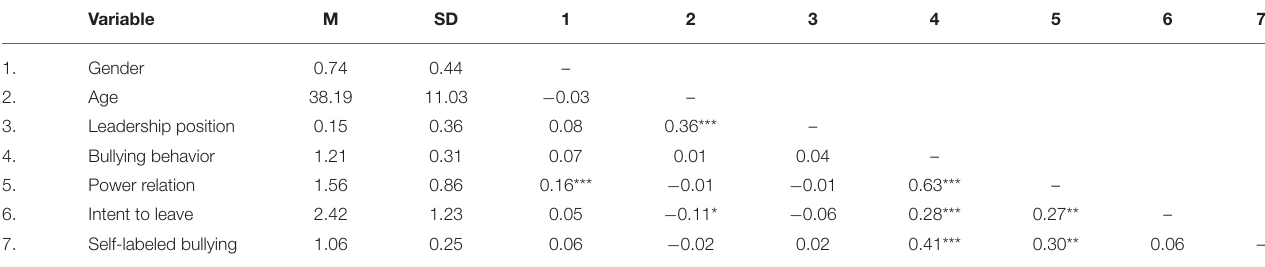
TABLE 1 | Descriptive statistics and intercorrelations for all study variables ( N = 374). Variable